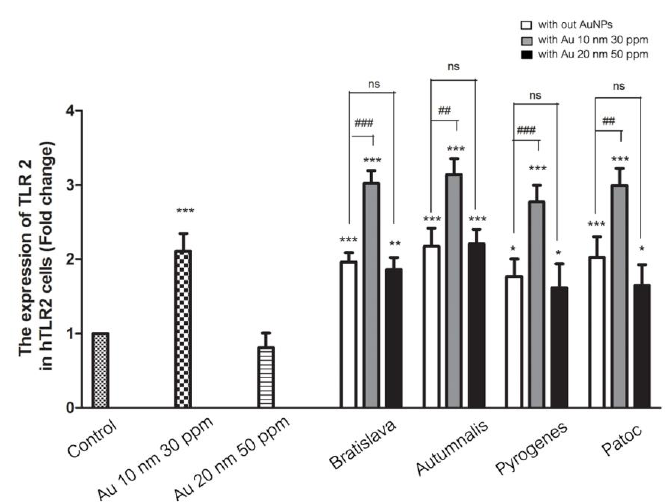
Figure 8. Effect of AuNPs on the Leptospira -induced TLR2 mRNA expression level in HEK-Blue-hTLR2 cells after 24 h treatment, as determined by two-stage qrt-RT-PCR and normalized to the GADPH housekeeping gene. Data are shown as the mean ± SD ( n = 6). Significance of the difference compared to the control group is shown as *, ** and *** for p < 0.05, p < 0.01 and p < 0.001, respectively. Significance of the difference and between with and without the presence of 10 nm AuNPs is shown as ## and ### for p < 0.01 and p < 0.001, respectively. ns = non-significant.